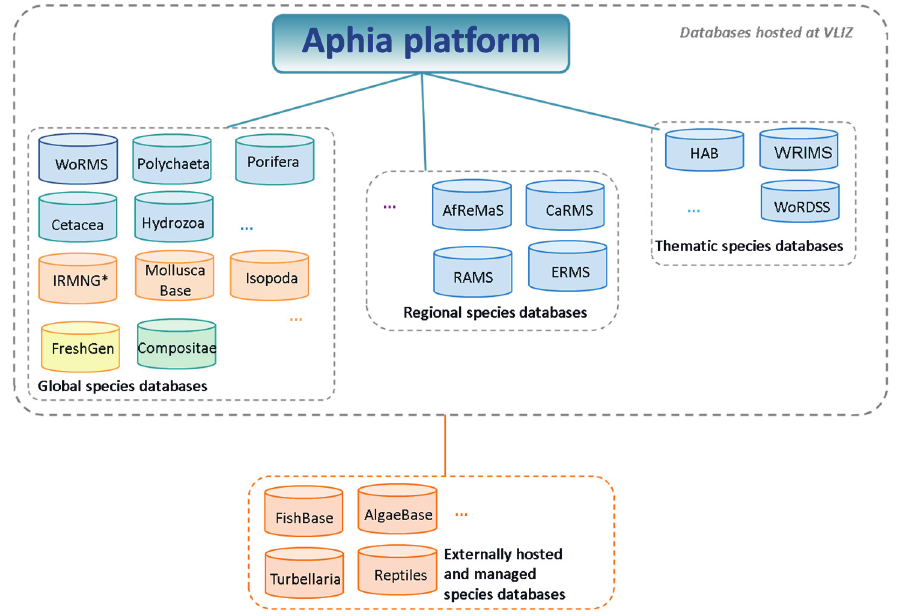
Figure 2. Conceptual representation of the relationships between the Aphia platform and its component databases. Blue: species database with focus on marine environment; Orange: species database dealing with all environments (marine-fresh-terrestrial); Yellow: species database with focus on freshwater environment; Green: species database with focus on terrestrial environment. WoRMS: World Register of Marine Species; IRMNG: Interim Register for Marine and Non-marine Genera; AfReMaS: African Register of Marine Species; CaRMS: Canadian Register of Marine Species; RAMS: Register of Antarctic Marine Species; ERMS: European Register of Marine Species; HAB: IOC-UNESCO Taxonomic Reference List of Harmful Micro Algae; WRIMS: World Register of Introduced Marine Species; WoRDSS: World Register of Deep-Sea Species. *: IRMNG is focused on genera, not